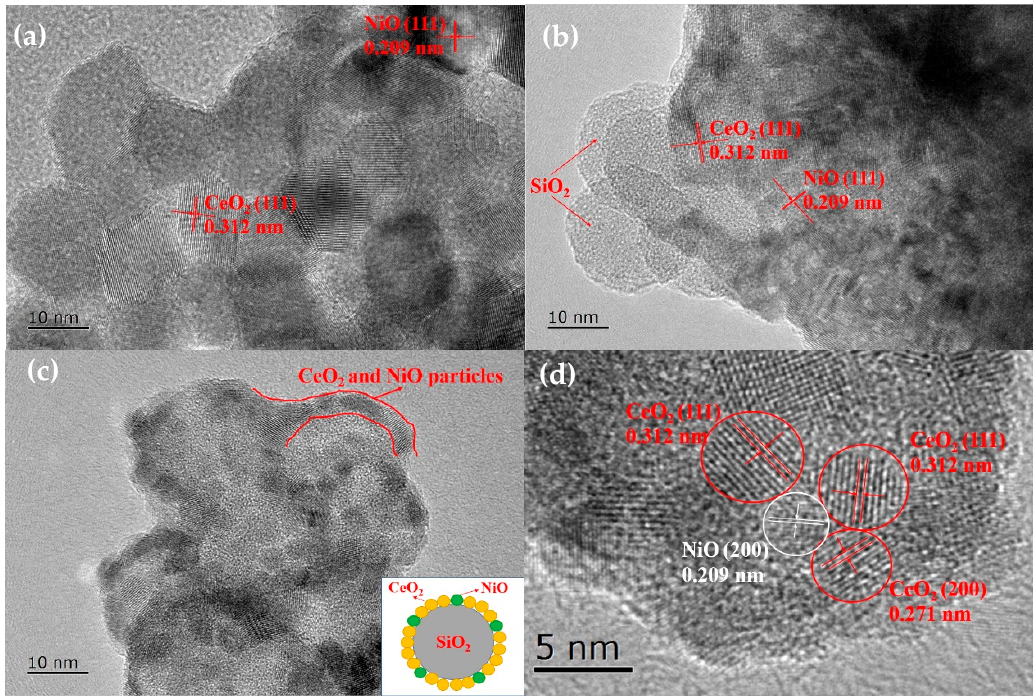
Figure 3. Transmission electron microscopy images of fresh catalyst: (a) Ni-CeO 2 (SC); (b) Ni-CeO 2 /SiO 2 (IM); and (c, d) Ni-CeO 2 /SiO 2 (CSC).